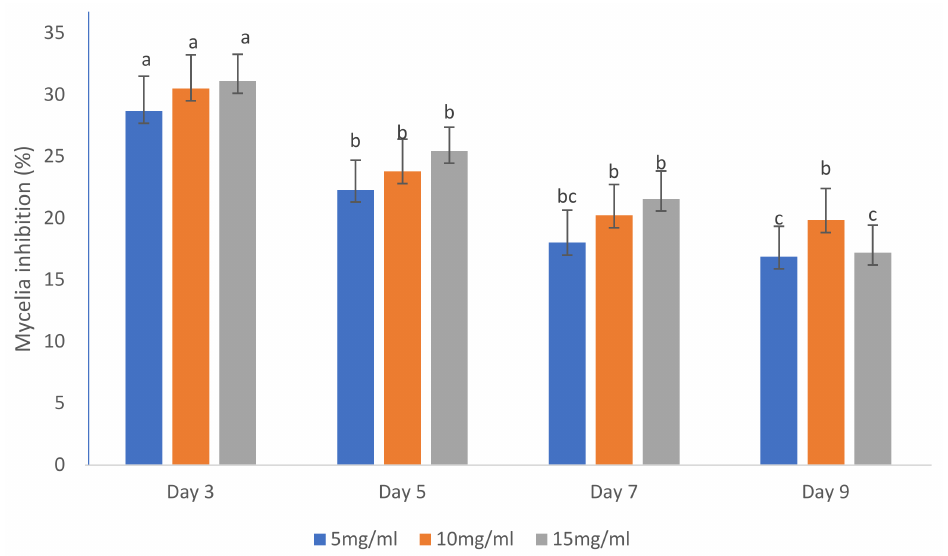
Figure 8. Heatmap showing the effect of days of observation on the percentage of fungal inhibi- tion at different concentration levels. Means with different letters across the days are significantly ( p < 0.05)